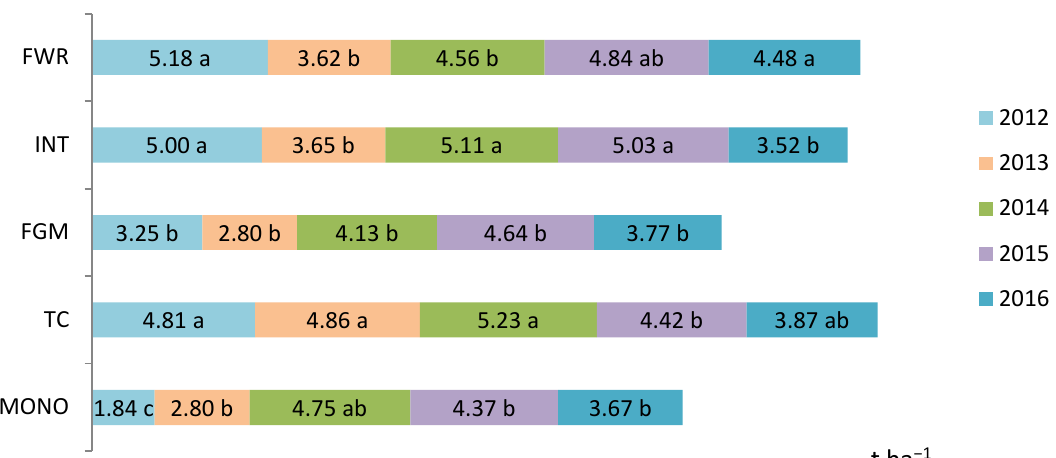
Figure 5. Winter rye grain yield in different crop rotations, 2012–2016. Note: different letters indicate significant differences between the treatments ( p ≤ 0.05); FWR—field rotation with row crops; INT—intensive rotation; FGM—rotation for green manure; TC—three-course rotation; MONO—rye monoculture.